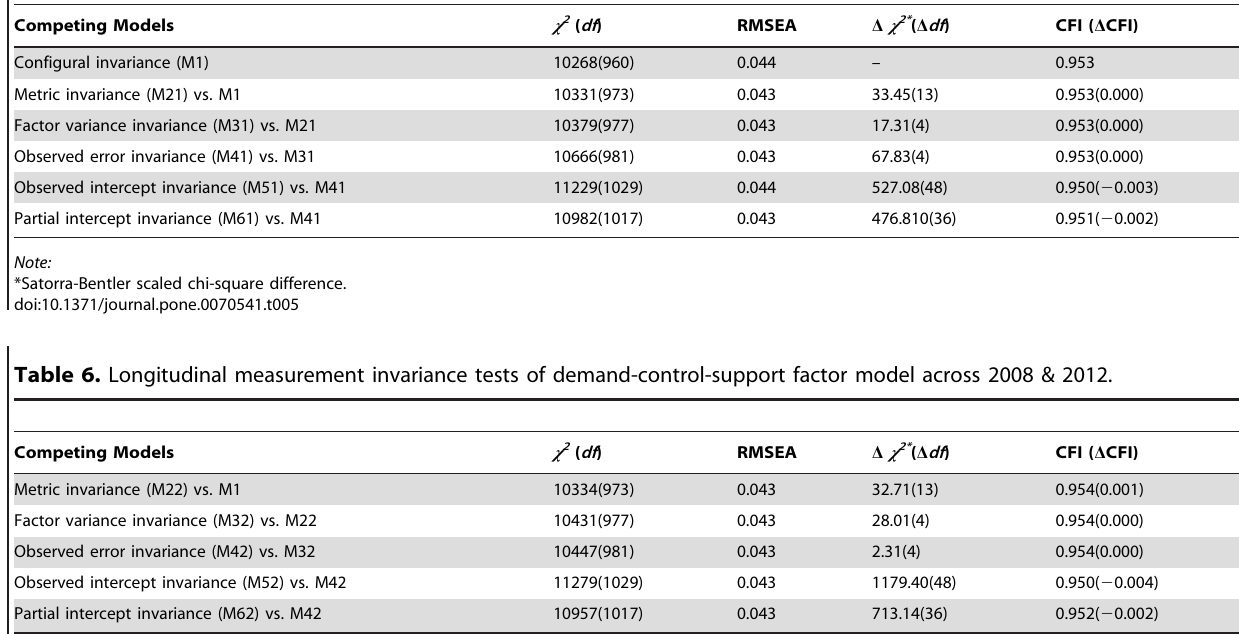
Competing Models Metric invariance (M21) vs. M1